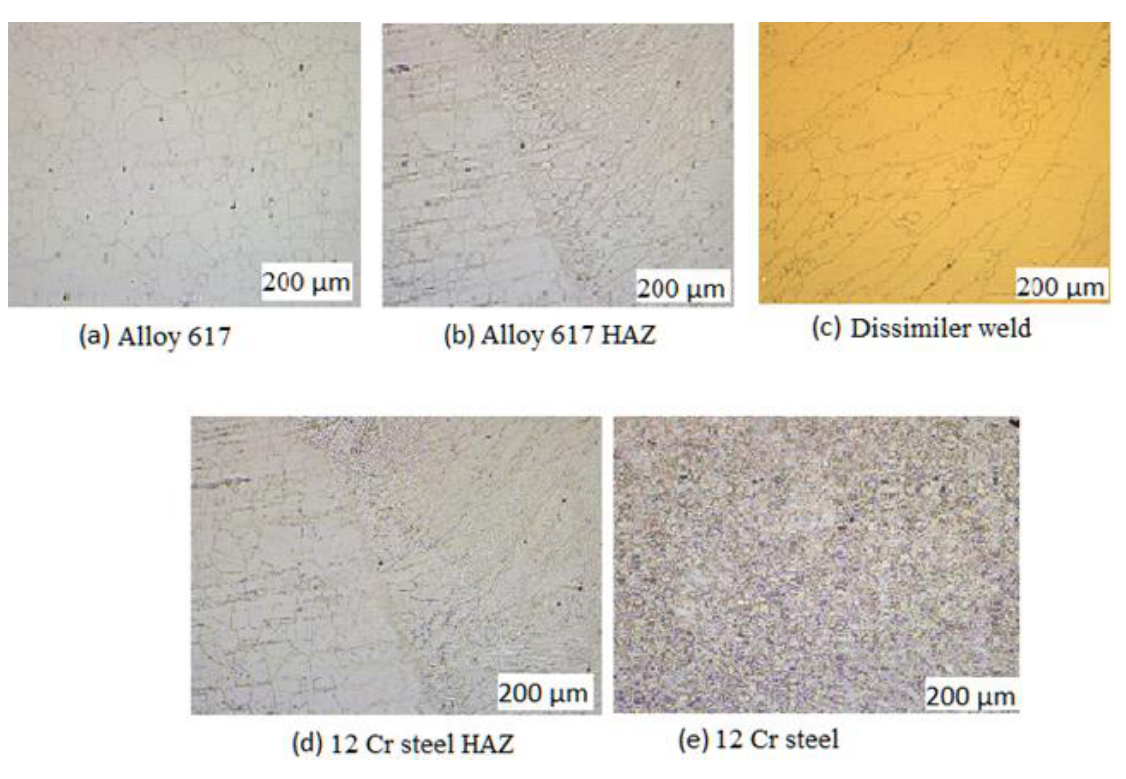
Figure 11. Microstructure observation results of dissimilar metal weld: ( a ) Alloy 617; ( b ) Alloy 617 HAZ; ( c ) Dissimilar material weld; ( d ) 12Cr steel HAZ; ( e ) 12Cr steel. Table 4. Composition analysis of dissimilar material welded joint (wt. %).